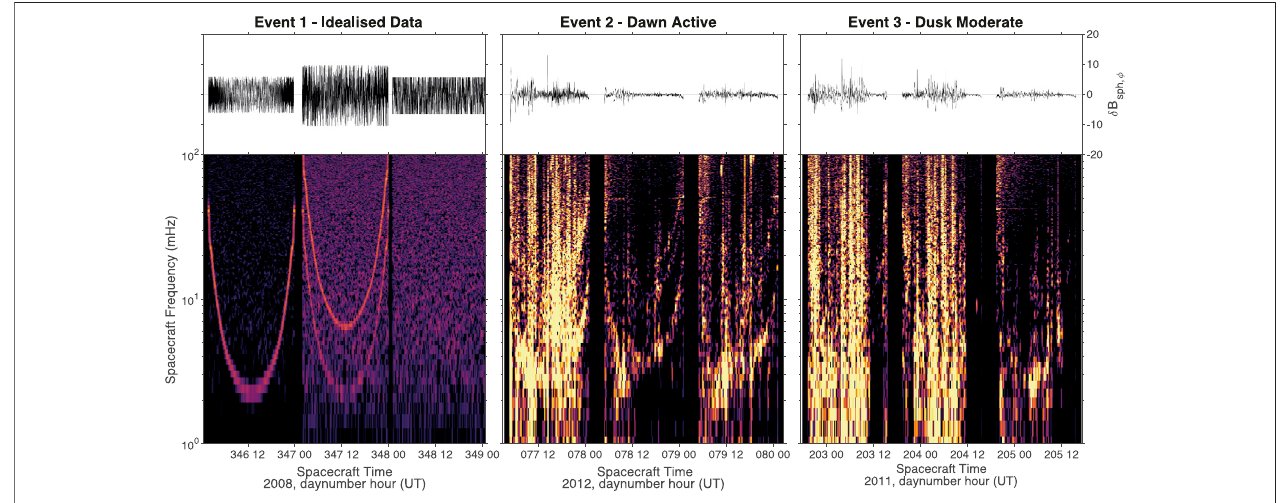
FIGURE 7 | The three example THEMIS ULF wave events used in the survey. Top panels show the azimuthal component of the magnetic fi eld with bottom panels showing its Short Time Fourier Transform spectrograms with a logarithmic colour scale, where the background has been spectrally whitened.